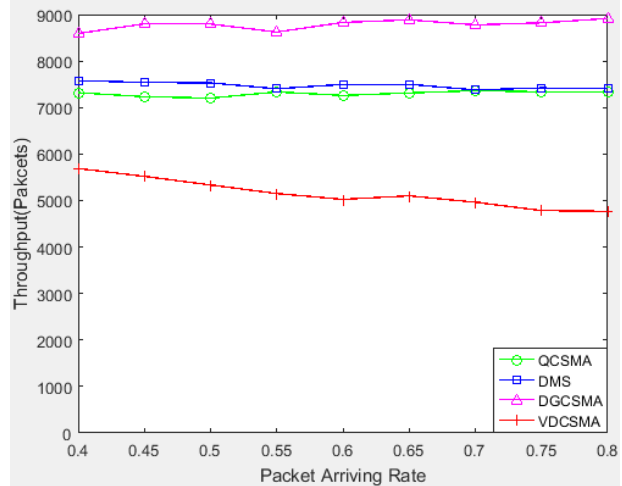
Figure 11. Throughput of non-real-time links: λ ∈ [ 0.4,0.8 ]